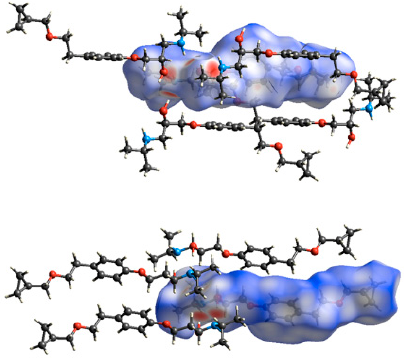
Figure 8. Hirshfeld surfaces of the BE_IV ( top ) and BE_I ( bottom ) together with the neighboring interacting molecules via hydrogen bonds and C-H ... π contacts.